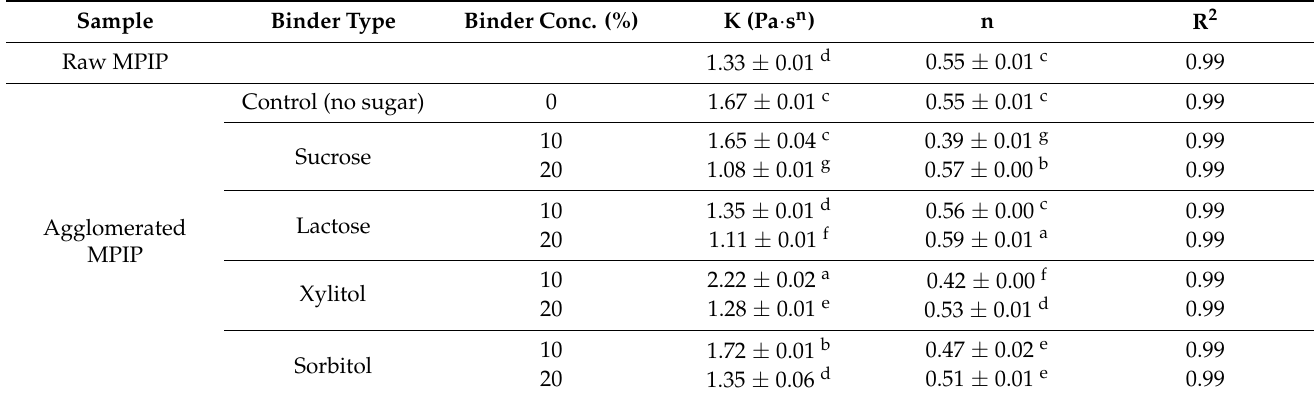
Table 4. Values of power law model parameters of raw and agglomerated MPIPs prepared with various sugar binders at various